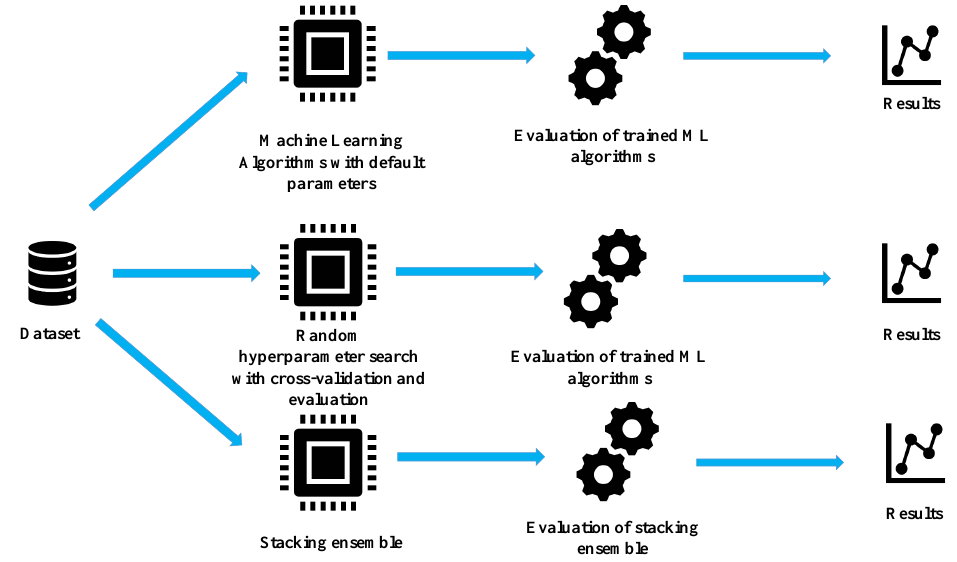
Figure 6. Graphical representation of research methodology